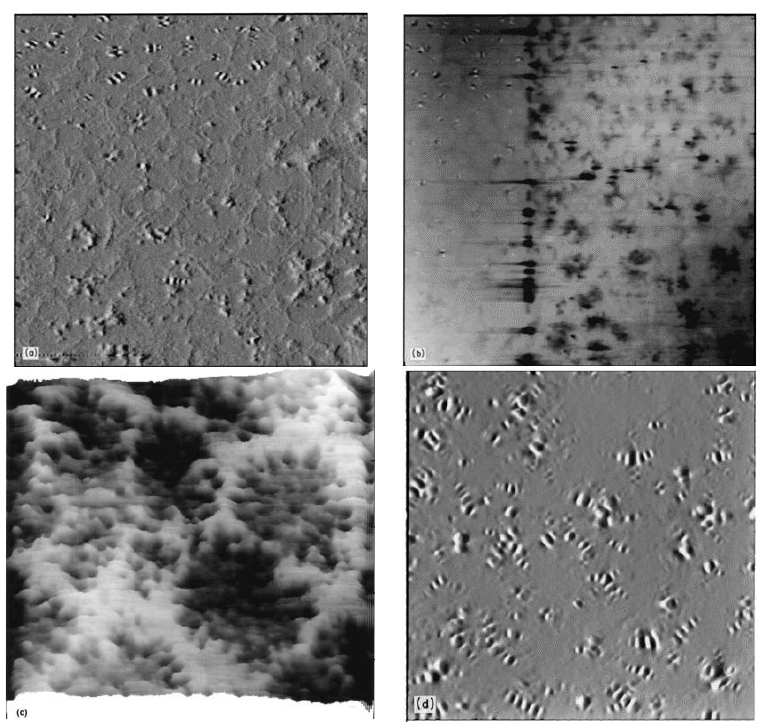
Figure 2. The microscopic images of asphalt surfaces. ( a ) AFM image of a gel asphalt taken by force mode. The bee-like structure is visible at the top. ( b ) AFM image of a gel asphalt taken by force mode. On the left side the bee-like structure is visible; on the right side the network structure appears. ( c ) AFM image of the same gel asphalt taken by the height mode after scanning at high magnification and presented in a 3D perspective view. ( d ) AFM tapping mode image of a gel asphalt. Reprinted with permission from [47]. © 2022 John Wiley and Sons-Books.